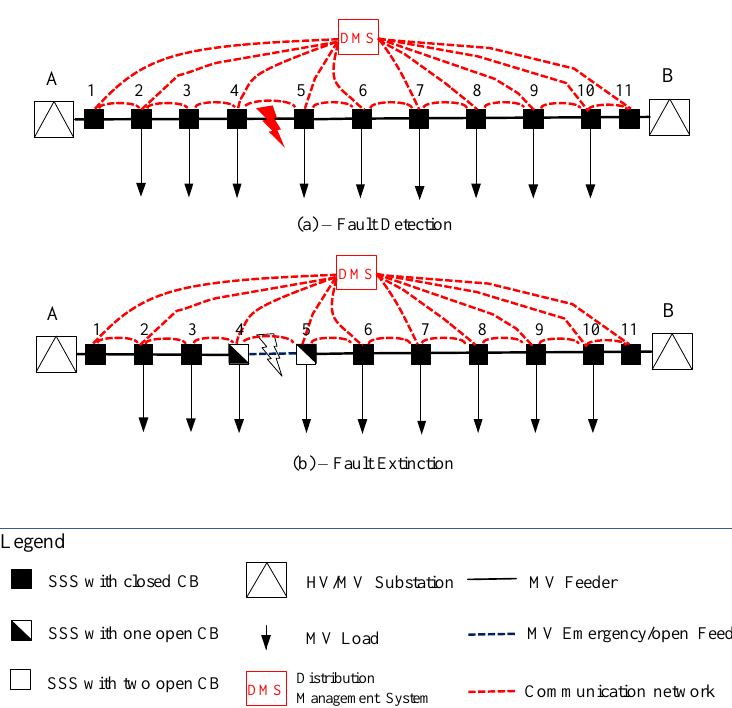
Figure 6. Fault detection and extinction in meshed distribution network.